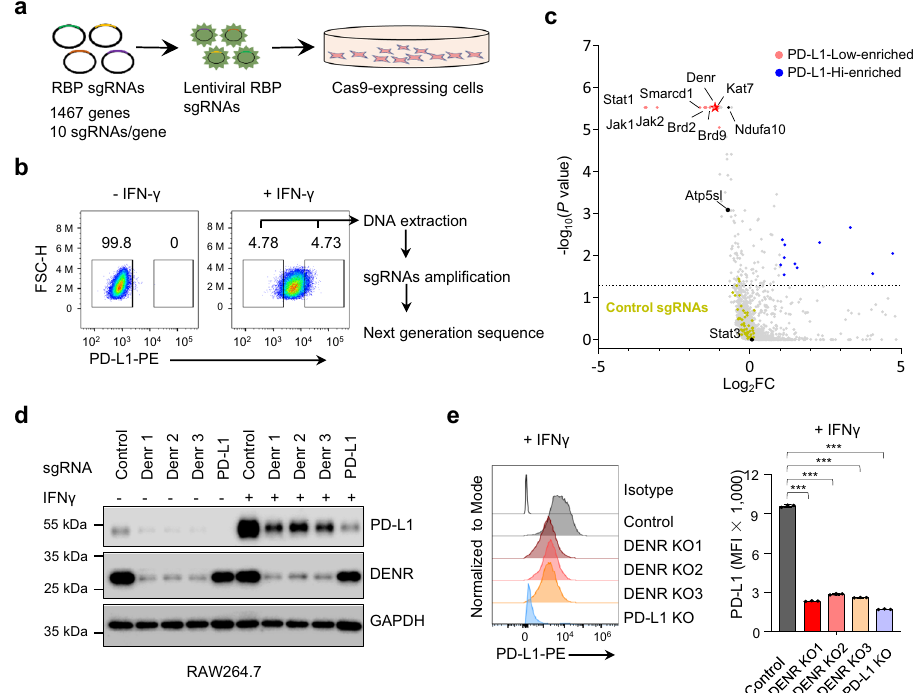
Fig. 1 Identi fi cation of DENR as a PD-L1 regulator by CRISPR/Cas9 screening. a Single-guide (sg)RNAs were packaged into a lentivirus and transfected into Cas9-expression RAW264.7 cells; cells were selected with puromycin (8 ng/ml) for 7 days. b RAW264.7 cells were incubated with 20 ng/ml IFN- γ for 4 h to induce PD-L1 at a moderate level; PD-L1 Low and PD-L1 High cells were sorted by FACS of IFN γ -treated cells, and the sgRNAs were ampli fi ed and sequenced. c Dots represent individual genes; red and blue dots indicate genes with signi fi cant enrichment within the PD-L1 Low and PD-L1 High populations, respectively; orange dots indicate negative control sgRNAs; black dots indicate Stat3 , Ndufa10, and Atps5l . The experiment was repeated independently two times with similar results. d Western blotting validation of DENR and PD-L1 knockout with speci fi c sgRNAs in RAW264.7 cells, ± IFN γ (20 ng/ml) for 24 h. The experiment was repeated independently three times with similar results. e Surface PD-L1 levels were analyzed by FACS in DENR and PD-L1 KO cells, + IFN γ (20 ng/ml) for 24 h ( n = 3 independent samples). Results are representative of three biological replicates. Three technical replicates are shown. Data are presented as mean values ± SD. Two-sided, one-way ANOVA with Dunnett ’ s post hoc test: *** p < 0.001. p values from left to right: <